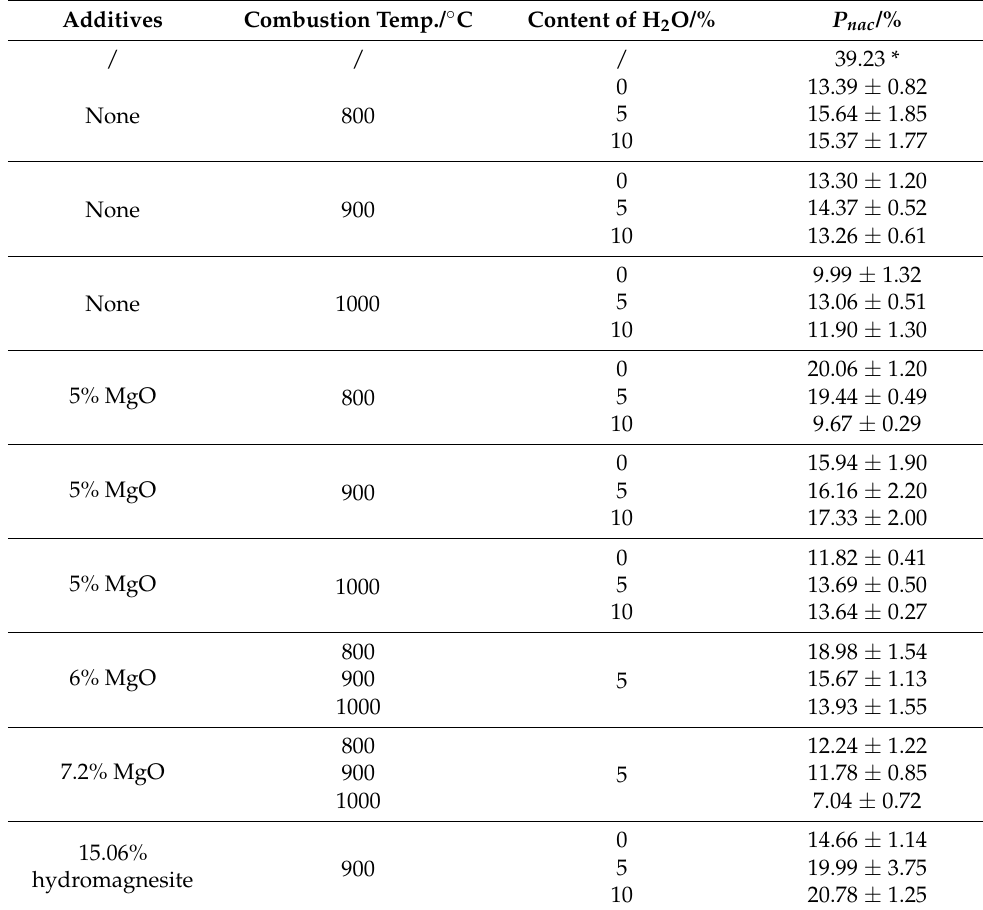
Table 3. Determination of bioavailable phosphorous content in SS and its ashes during combustion.